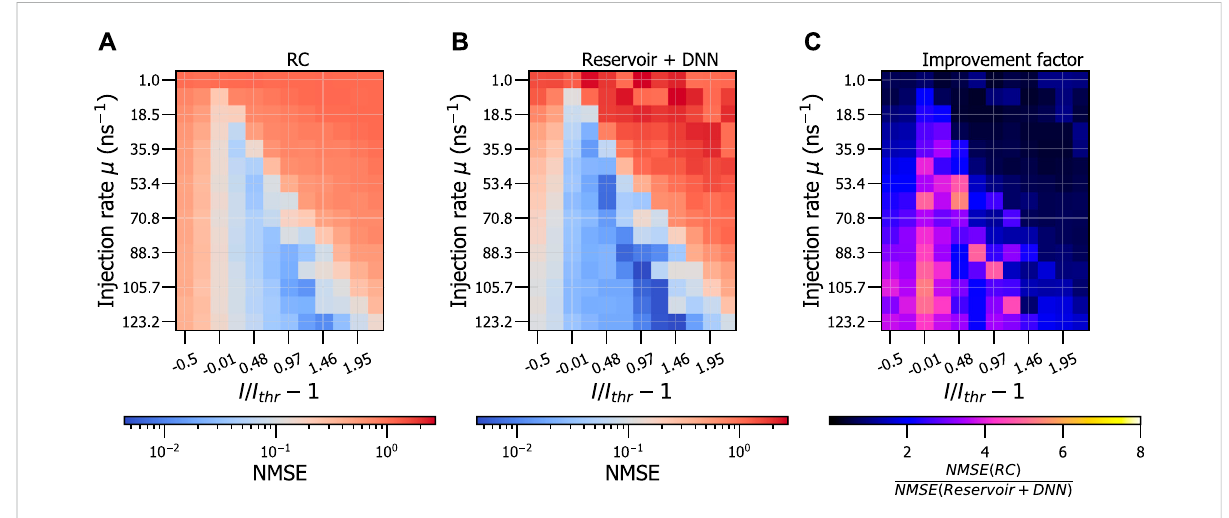
FIGURE 3 NMSE resulting from a grid search of injection rate and pump current, at constant feedback rate η =7.8 ns − 1 , for conventional RC (A) , for the photonic reservoir coupled with the DNN (trained for 1.6 ×10 4 epochs) (B) and the improvement factor of the reservoir combined with the DNN compared to the RC system (C) .